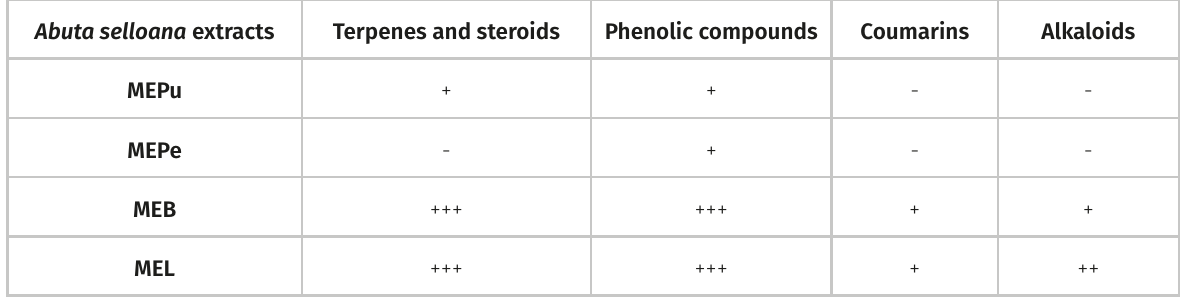
Table I. Preliminary phytochemical profile of the methanolic extracts obtained from different parts of A. selloana. Abuta selloana extracts Terpenes and